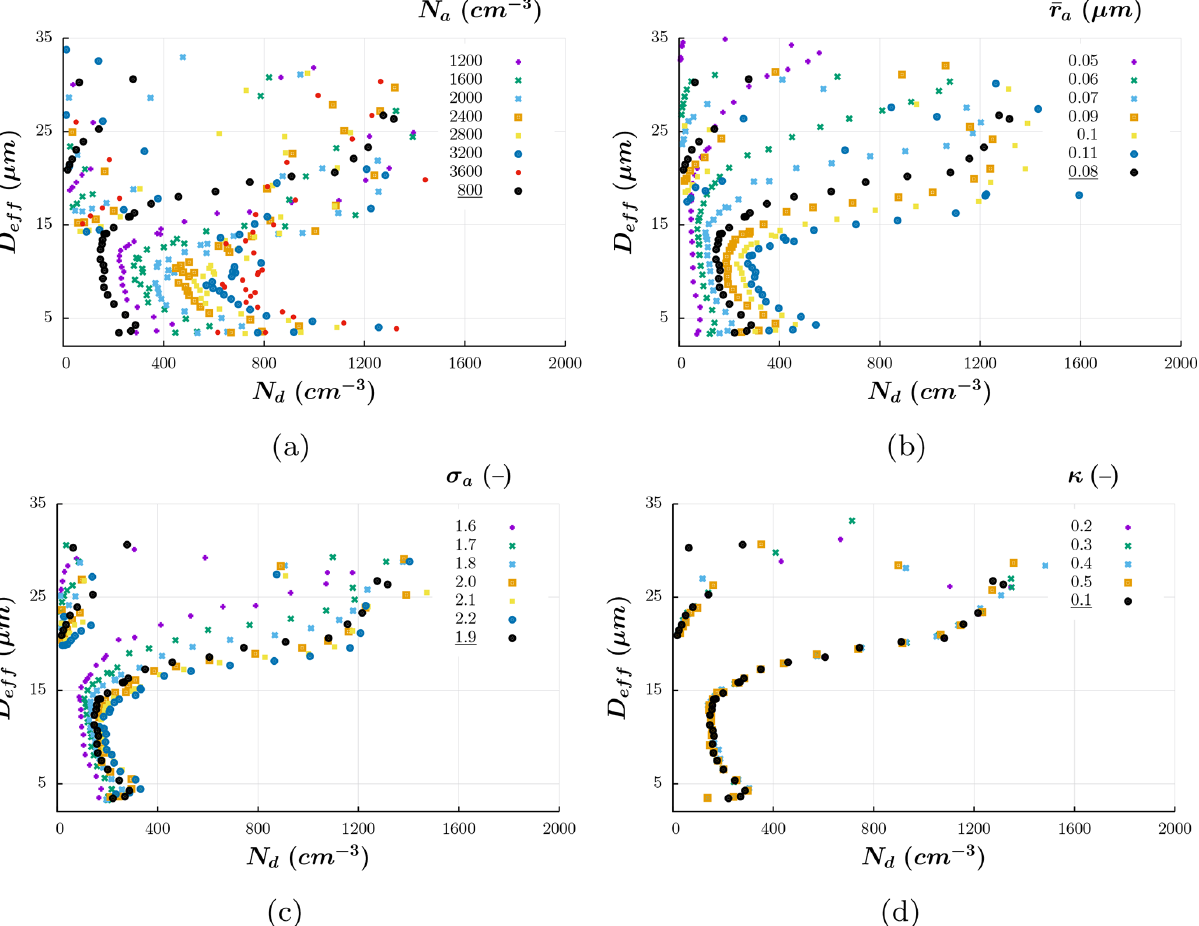
Figure 3. Illustration of the sensitivity of cloud top bulk properties to (a) the aerosol number concentration (cm − 3 ), (b) the median radius of the PSD ( µ m), (c) the geometric standard deviation of the PSD (–) and (d) the aerosol hygroscopicity (–). The markers represent the averaged DSDs for the time steps when the cloud top remains at the same model level during its growth. The colors distinguish between simulations using different values of the parameter specified at the top of the graphs. The control simulation is represented by black markers in the